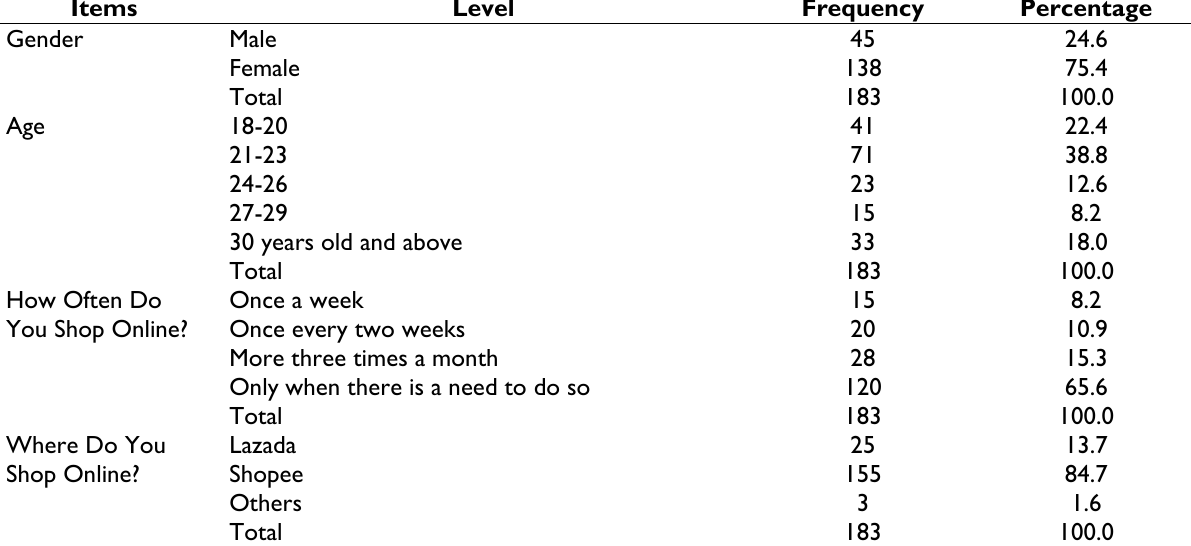
Table 2: Respondent